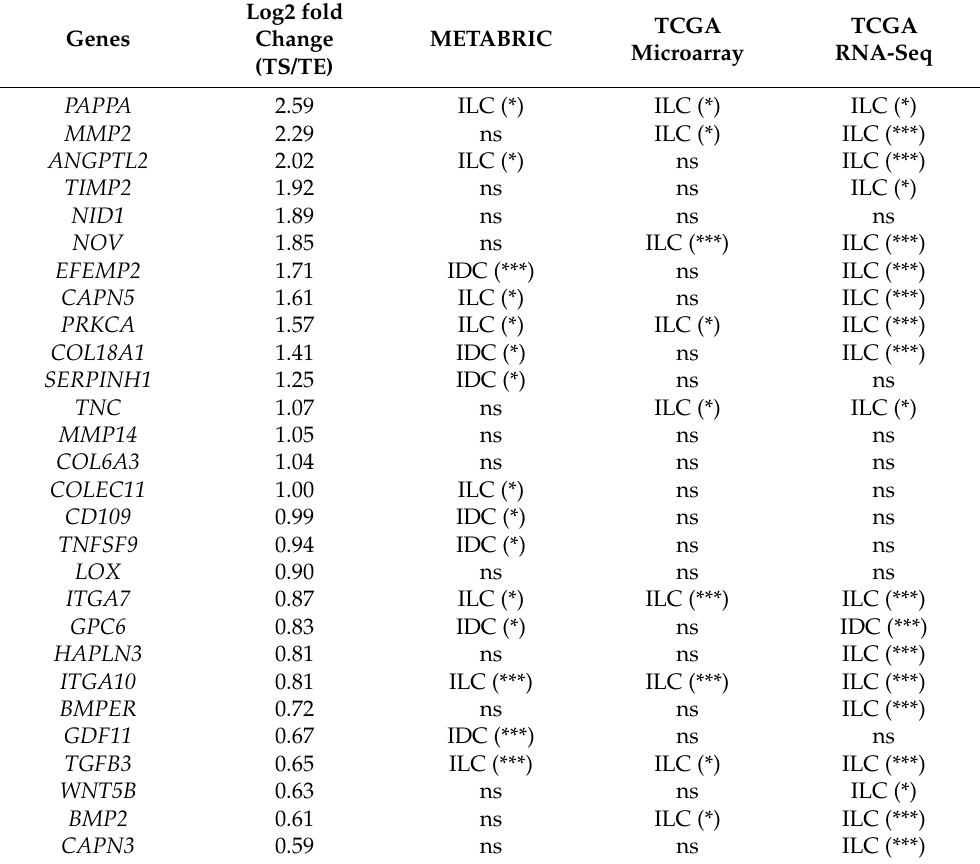
Table 1. Relative expression of CAF genes enriched in the stroma of ILC in ER+ ILC and IDC tumors. Log 2 (fold changes) indicate log 2 (TS/TE) gene expression changes in the LCM-ILC dataset. All genes in LCM-ILC dataset were significantly enriched in TS vs. TE by rank products (pfp < 0.01). Significance levels shown for individual gene expression levels in METABRIC and TCGA bulk tumor datasets. ILC or IDC indicates significant increase in gene expression in that subtype;